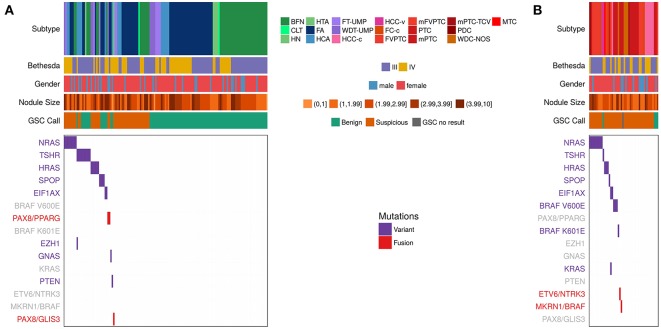
Expressed Variants and fusions observed in RNA-seq data among the n = 191 Afirma GSC clinical validation study cohort, including the 1 sample classified as GSC no result due to inadequate follicular content (25), which is a subset of the 943. Each column represents a sample, while each row is either clinical information or a variant or fusion. Samples positive for a variant have a purple hash, while samples positive for a fusion have a red hash. Negative for a variant or fusion are white. Clinical information includes subtype, Bethesda category (III and IV only), Nodule size in cm, and GSC call. See Table 1 for a list of subtype abbreviations. Variants/fusions are grayed out if no samples in a given cohort were positive for that alteration. (A) Histologically benign subtypes. (B) Histologically malignant subtypes.